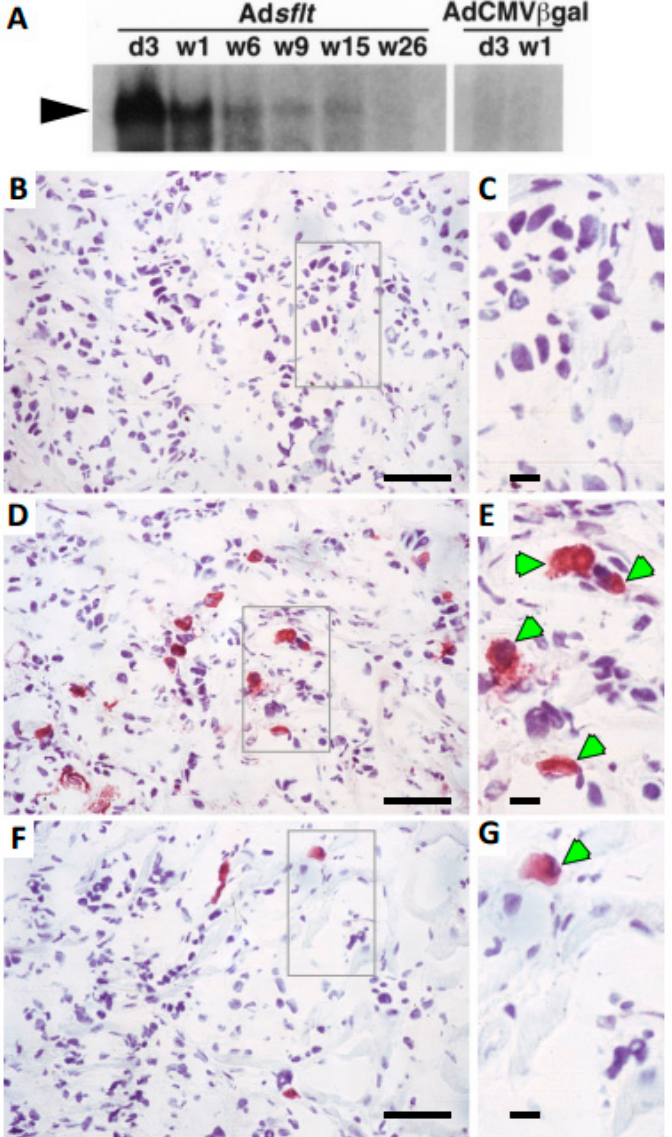
Figure 4. Analysis of sflt-1 mRNA and protein expression in Ad sflt -treated mammary tumors. ( A ) Northern blot analysis of sflt-1 mRNA expression in vivo. RNA was isolated from single Ad sflt - or AdCMV. β gal-treated tumors at the indicated time points. sflt-1 mRNA was markedly expressed in mammary tumors from day 3 up to 6 weeks after Ad sflt injection and was still detectable 15 weeks after treatment. RNA from AdCMV. β gal-treated mammary tumors was used as a negative control. d, day; w, week. ( B – G ) Immunohistochemical staining of representative sections from mammary tumors inoculated with control Ad virus ( B , C ) or Ad sflt ( D – G ). Positive (red) staining indicates the expression of sFLT-1 protein in tumor sections at 7 days (panels ( B – E ); indicated with green arrows in ( C )) and 3 weeks (panels ( F , G ), indicated with green arrow in ( G )) after treatment. Total magnification is ~846× for left-hand panels ( B , D , F ); gray boxes indicate inset areas shown in right-hand panels ( C , E , G ) at ~1836× total magnification. Black bars = 10 mm in panels ( B , D , F ) or 2 mm in panels ( C , E , G ).